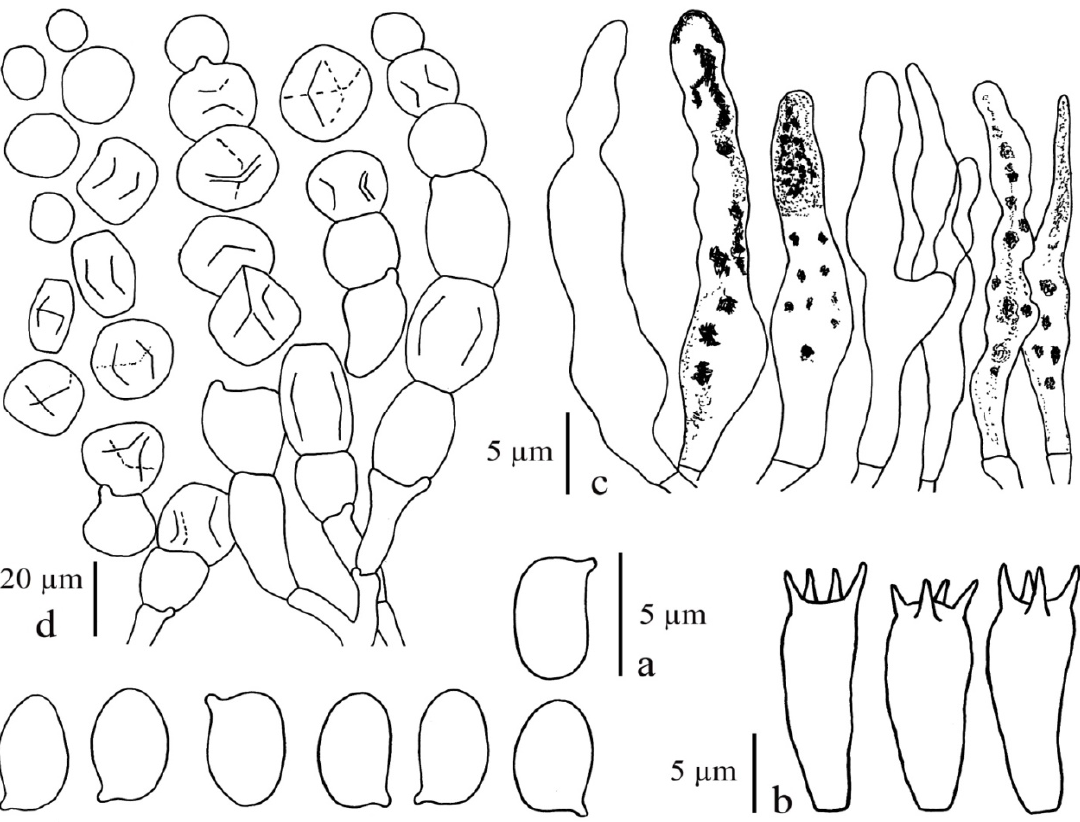
Figure 7 . Cystolepiota rhodella (HNL503227, holotype) ( a ) = basidiospores, ( b ) = basidia, ( c ) = cheilocystidia, ( d ) = pileus covering elements.